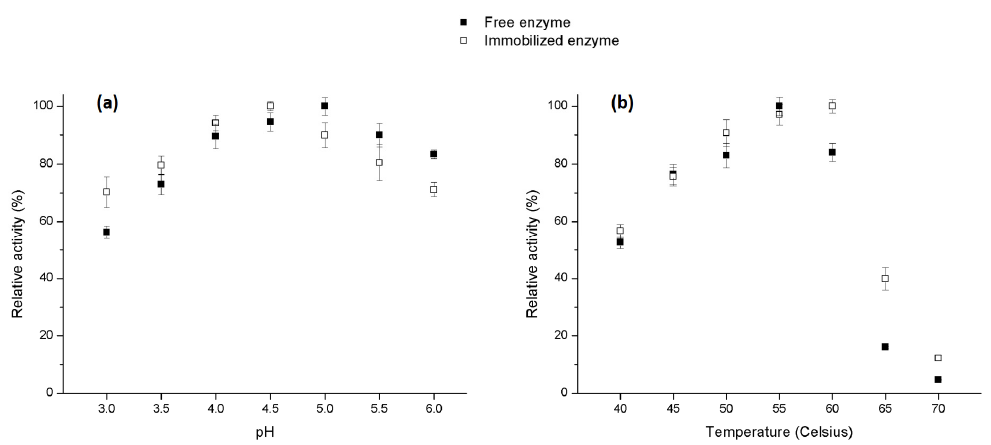
Figure 2. Effect of pH ( a ); and temperature ( b ) on the hydrolytic activity of the free (closed squares) and immobilized (open squares) enzyme. pH was evaluated in the range of 3.0 to 6.0, at a temperature of 50 °C and temperature was assessed at temperatures ranging from 40 to 70 °C at pH 4.5. Experiments were performed in triplicates, at a flow rate of 3.5 mL·min − 1, and error bars represent the standard deviation.